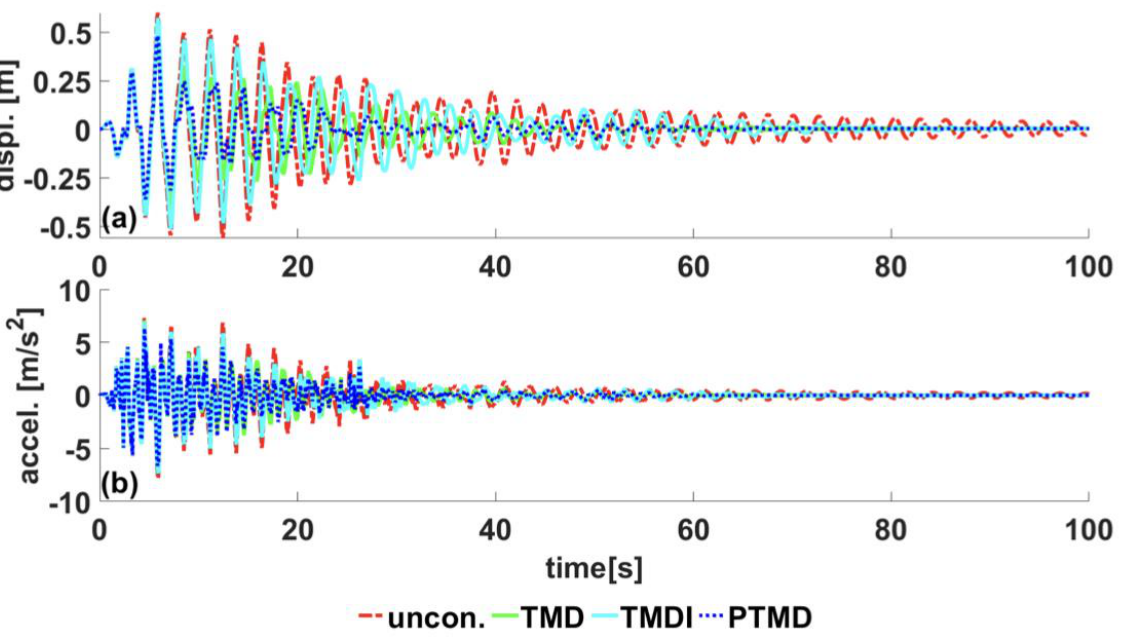
Figure 16. Uncontrolled and controlled displacement and acceleration responses of the 42nd floor, in the time domain, under El-Centro earthquake excitation: ( a ) displacement response and ( b ) acceleration response.